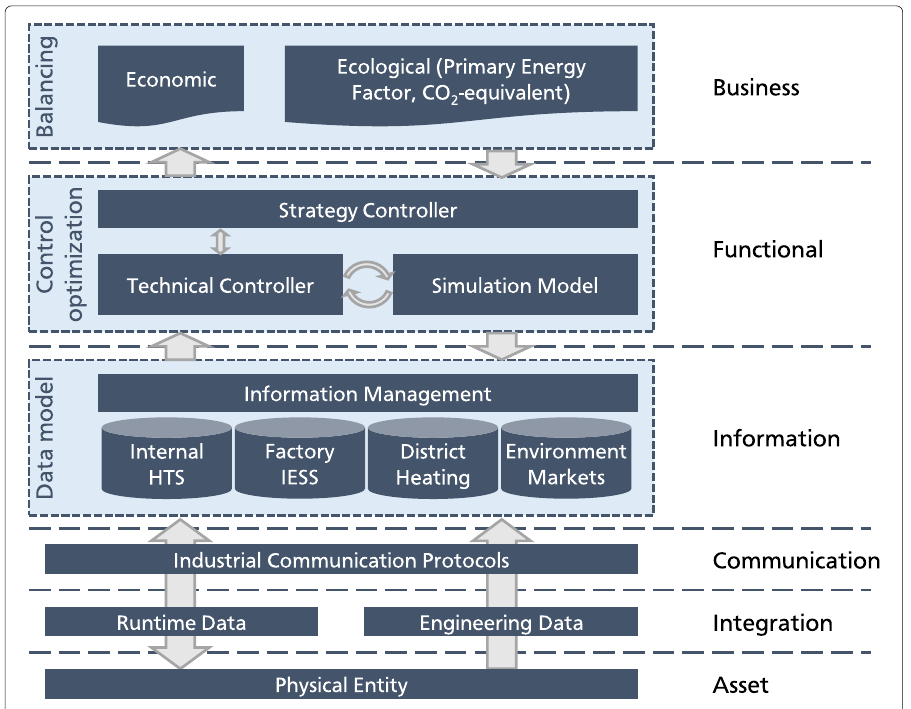
Fig. 2 Digital twin of the industrial heat transfer station integrated into the layer system of the RAMI4.0 based on Steindl et al.